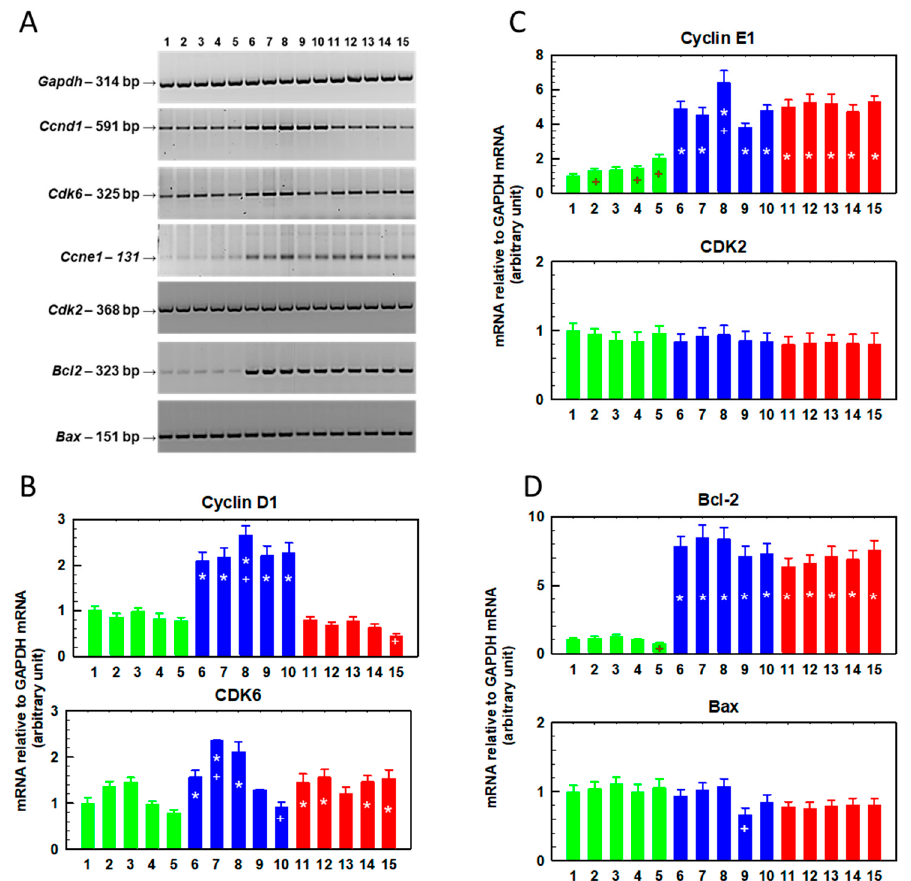
Figure 3. Changes in the relative gene expression of Ccnd1 (for cyclin D1), Cdk6 (for cyclin-dependent kinase 6), Ccne1 (for cyclin E1), Cdk2 (for cyclin-dependent kinase 2), Bcl2 and Bax in S, R and T cells cultured once in SFN-containing medium followed by further cultivation in SFN-free medium. The cells were cultured for 48 h in the presence of SFN at the following concentrations: (1) 0.0 μ M S cells, (2) 2.5 μ M S cells, (3) 5.0 μ M S cells, (4) 7.5 μ M S cells, (5) 10.0 μ M S cells, (6) 0.0 μ M R cells, (7)